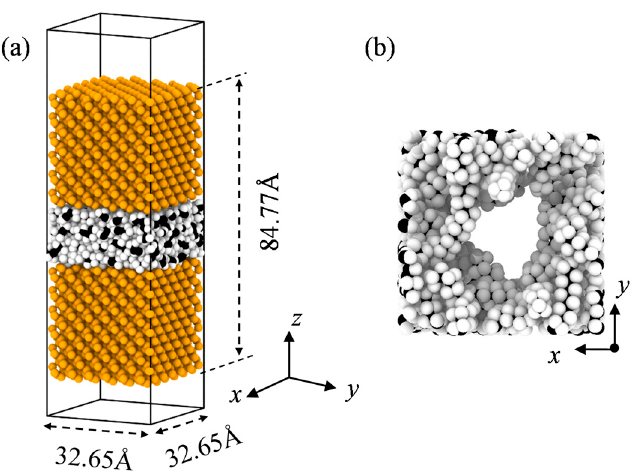
Figure 1. ( a ) The simulation model setup for the thermal relaxation method. ( b ) Top view of a single vacuole model.